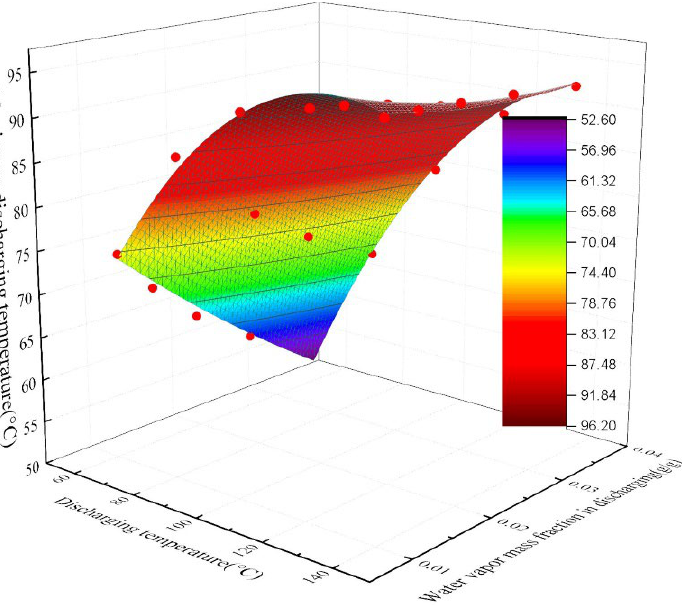
Figure 14. Three-dimensional curved surface of maximum discharging temperature as a function of the water vapor mass fraction and charging temperature in the charging process.